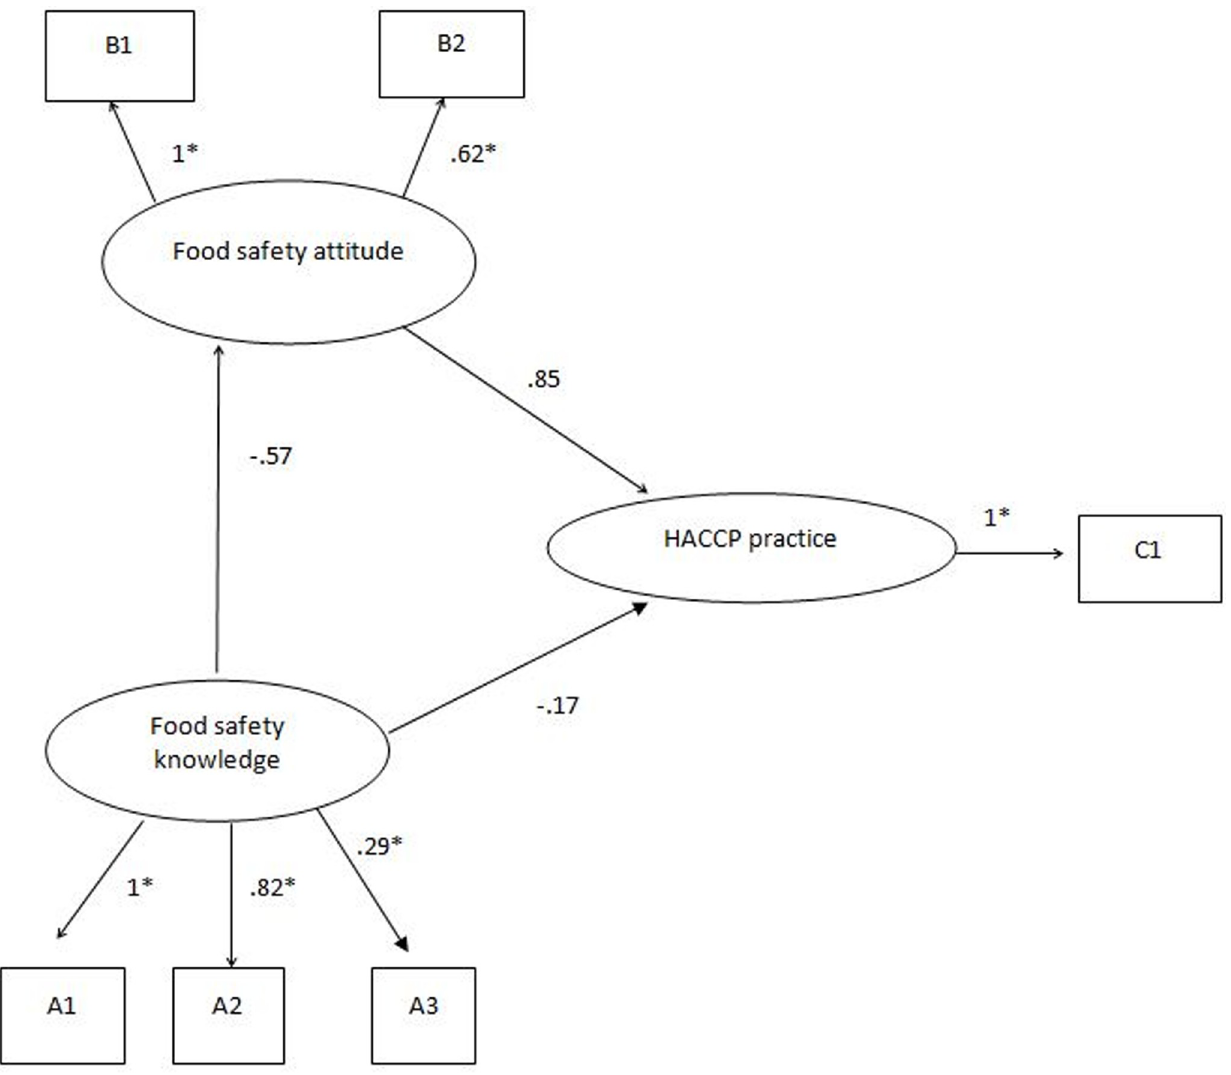
Fig 2. Model of food safety knowledge, attitude, and HACCP practice. A1: Food poisoning knowledge; A2: GHP knowledge; A3: HACCP knowledge; B1: Self-improvement attitude; B2: Food safety concern; C1: HACCP